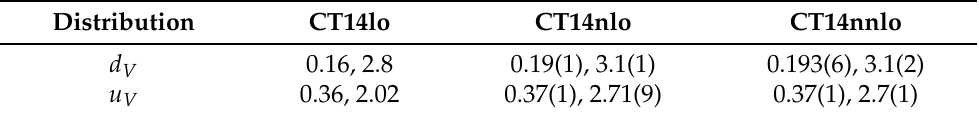
Table 1. A pair of parameters ( C , D ) of Equation (10) for valence d-quark and u-quark distributions in the proton. Uncertainties (last digit in the parentheses) represent the 68% confidence level are obtained through (where appropriate) the parton distribution function’s Hessian eigenvector set., There are no uncertainties available for the CT14lo